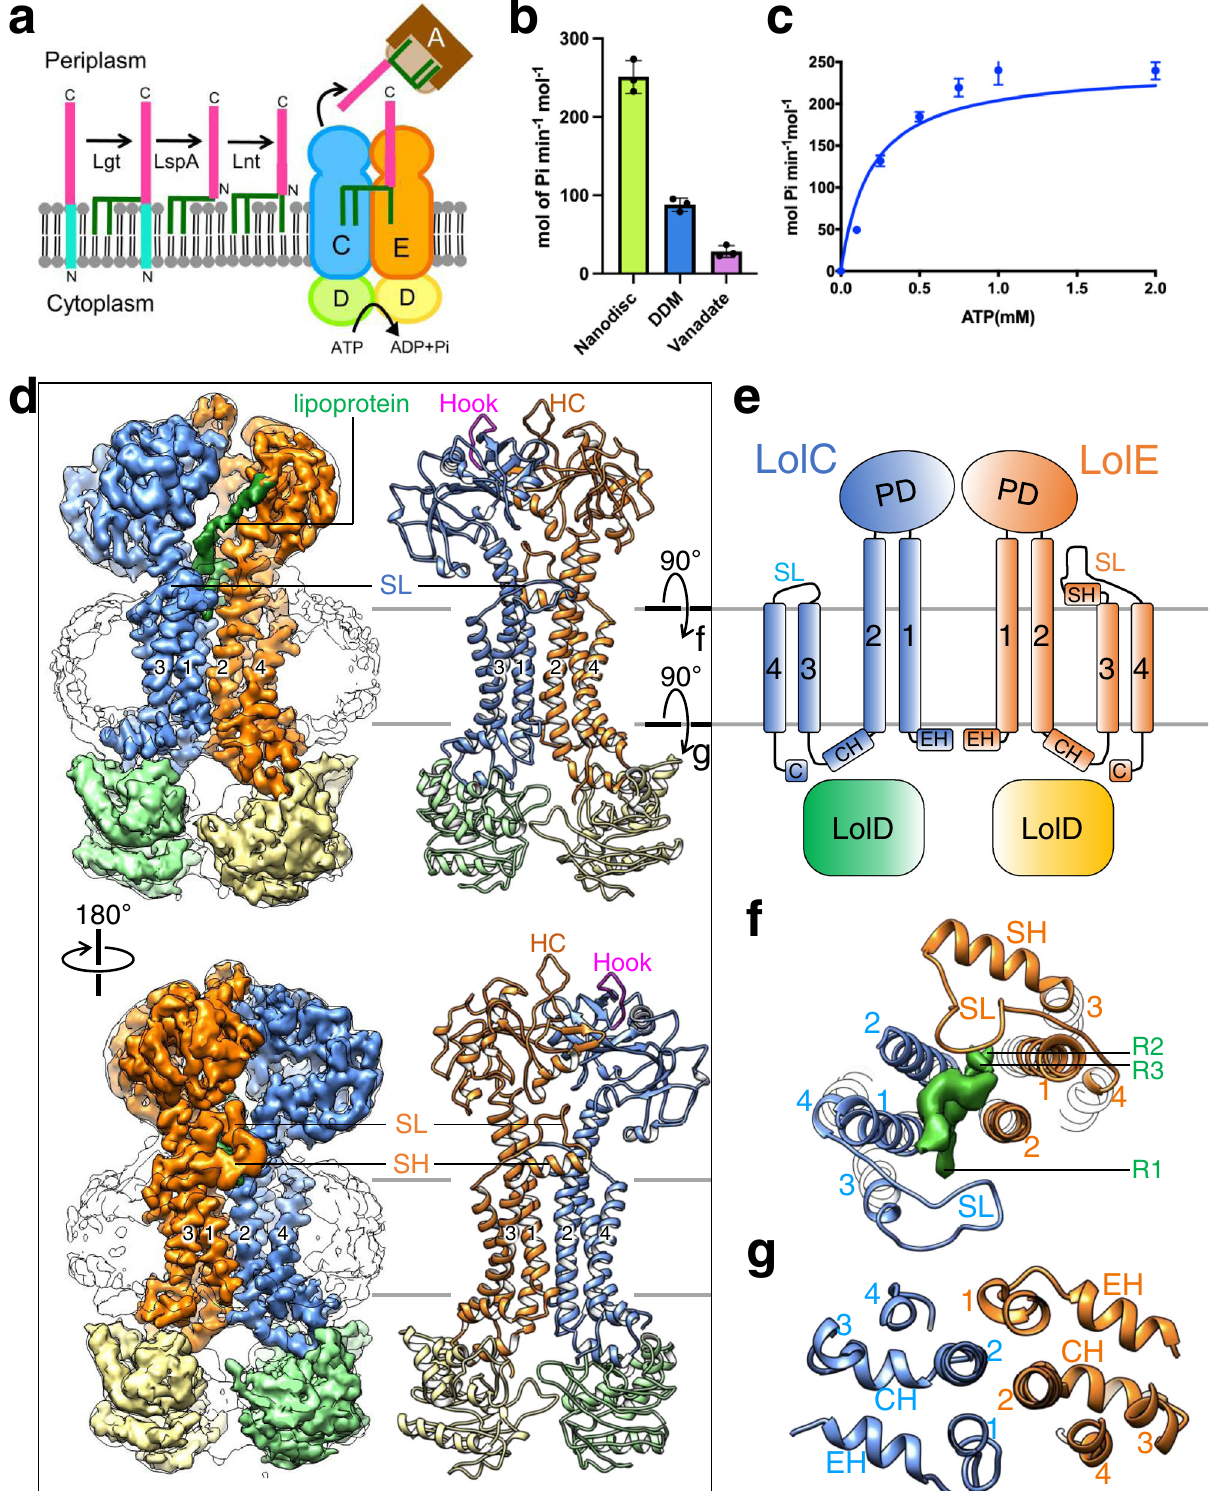
between TM3 and TM4. In the center of LolCDE are TM1 and TM2, against which TM3 and TM4 are packed (Fig. 1f). The overall structure and TMD topology of LolCDE are similar to transporters 19,20 (Supplementary Fig.